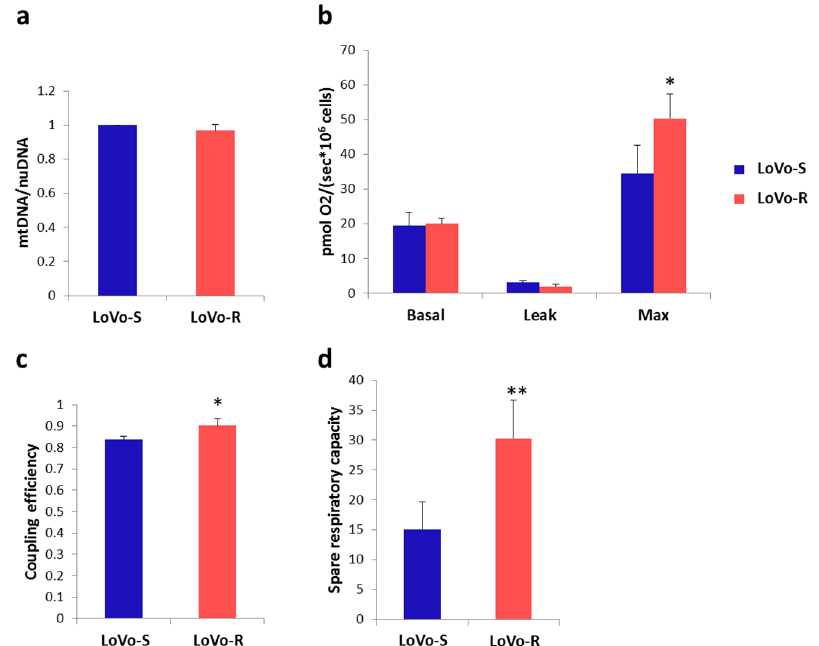
Figure 5. Oxygen consumption in LoVo cells. ( a ) mtDNA quantification by quantitative Polymerase Chain Reaction (qPCR) on total DNA extracted from LoVo-S and LoVo-R ( n = 3 experiments); ( b ) Oxygen fluxes following oligomycin (0.5 μm), stepwise titration of the chemical uncoupler FCCP (0.5 μm), and rotenone (0.5 μM)/antimycin A (2.5 μm) were recorded; ( c ) Mitochondrial coupling efficiency representing the respiratory fraction that leads to ATP synthesis ( n = 5 experiments); ( d ) Spare respiratory capacity as the result of the subtraction of the basal respiration from maximal respiration rates.